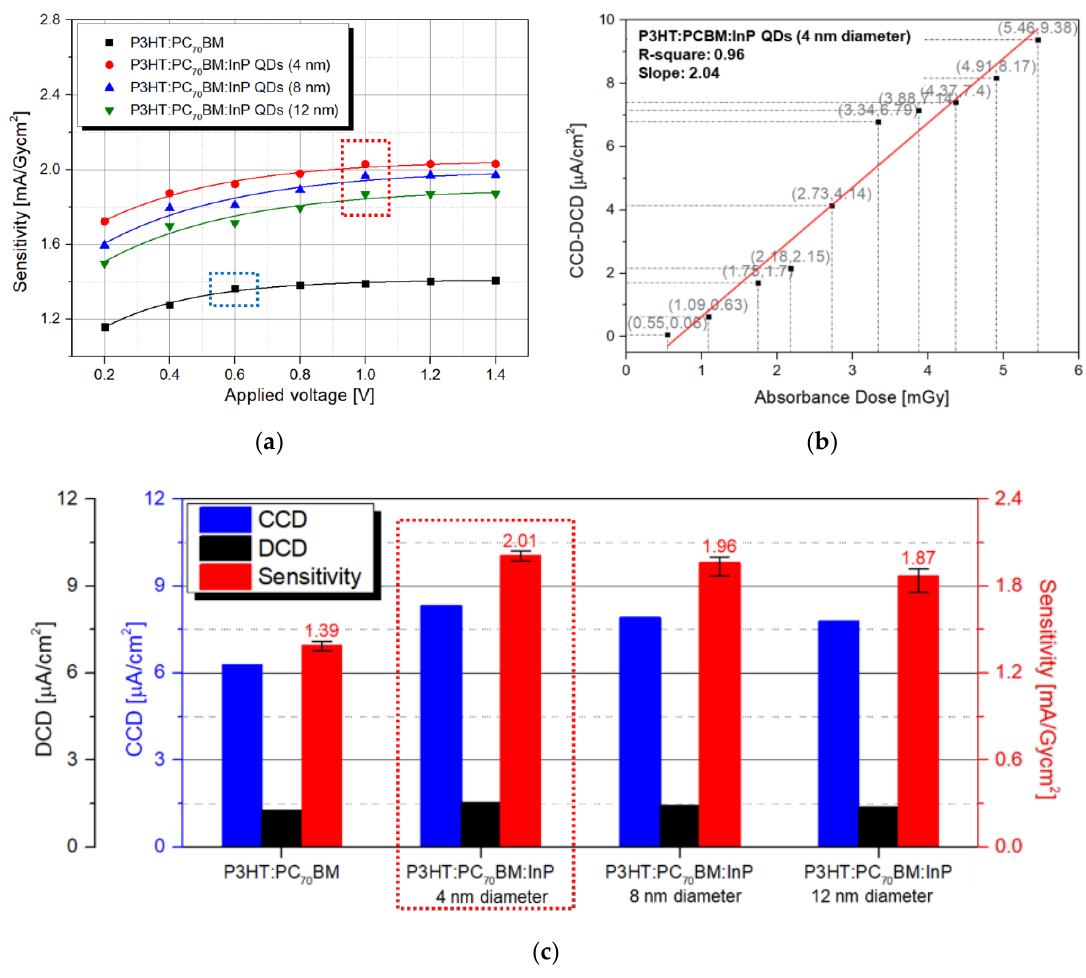
Figure 5. ( a ) A graph of the change in detector sensitivity according to applied voltage and ( b ) CCD–DCD value of the detector with P3HT:PC 70 BM:InP QDs (4 nm diameters) depending on the absorbed dose and ( c ) X-ray parameters, such as DCD, CCD, and sensitivity according to the pristine P3HT:PC 70 BM and P3HT:PC 70 BM:InP QDs (4, 8, and 12 nm diameter).